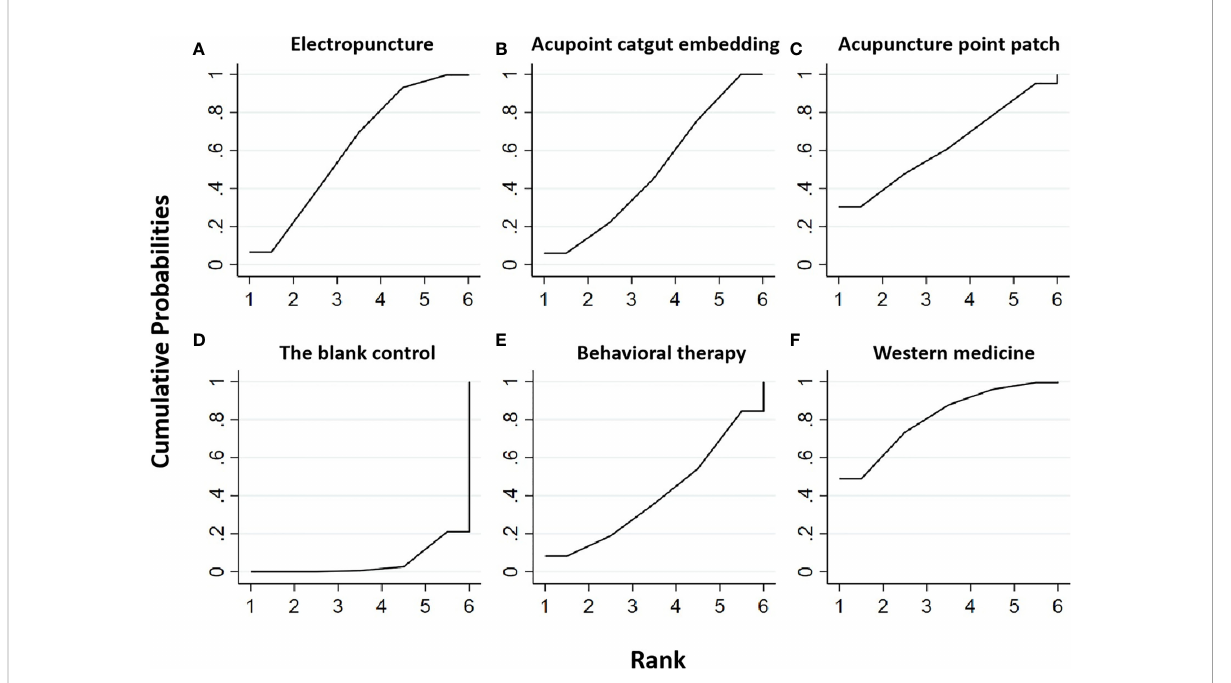
FIGURE 3 Ef fi cacy ranking and cumulative probability graph of fasting blood glucose (FBG) treated by different types of intervention. Comparison of ef fi cacy ranking and cumulative probability of FBG between each kind of intervention. (A) Electropuncture, (B) acupoint catgut embedding, (C) acupuncture point patch, (D) the blank control, (E) behavioral therapy, and (F) western